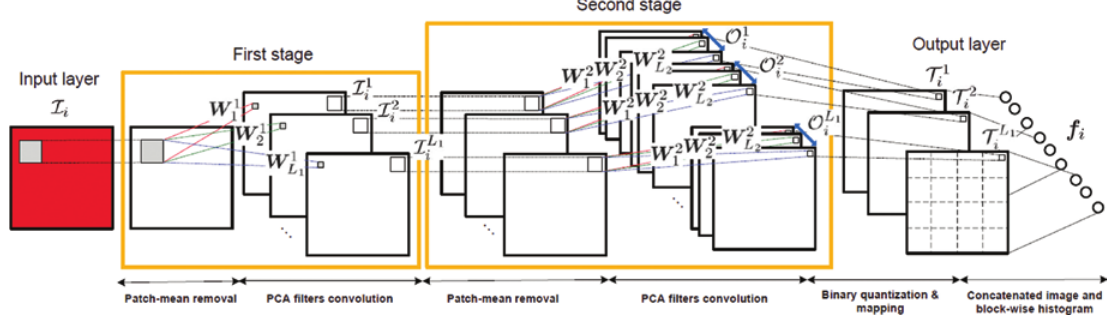
Figure 2: The structure of the two-stage PCANet.